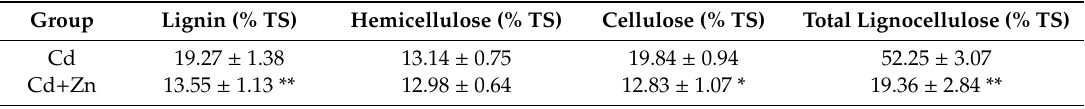
Table 2. Average contents of cellulose, hemicellulose, lignin, and total lignocellulose during the